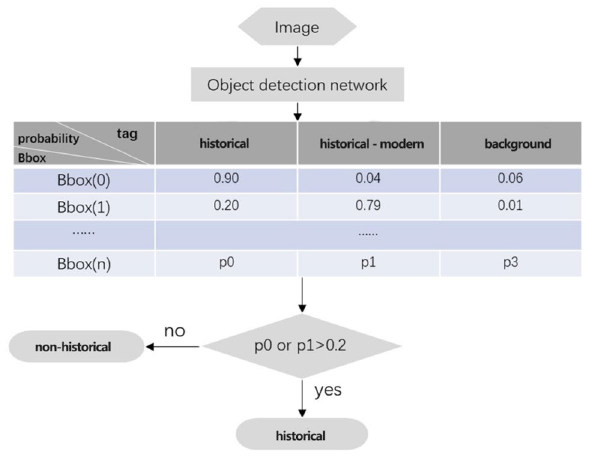
Fig. 12 Process after object detection